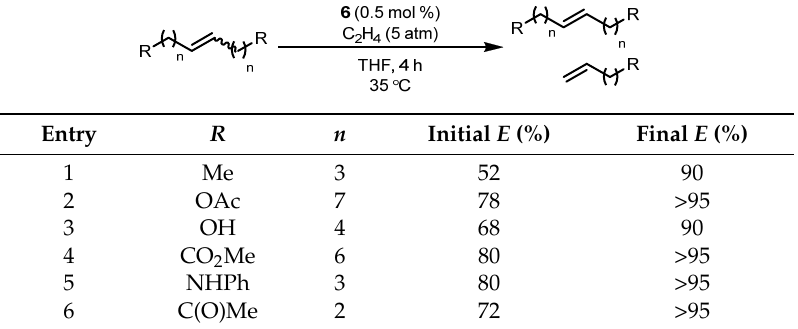
Table 6. Z -Selective ethenolysis of symmetric internal olefins providing E -isomer enrichment.